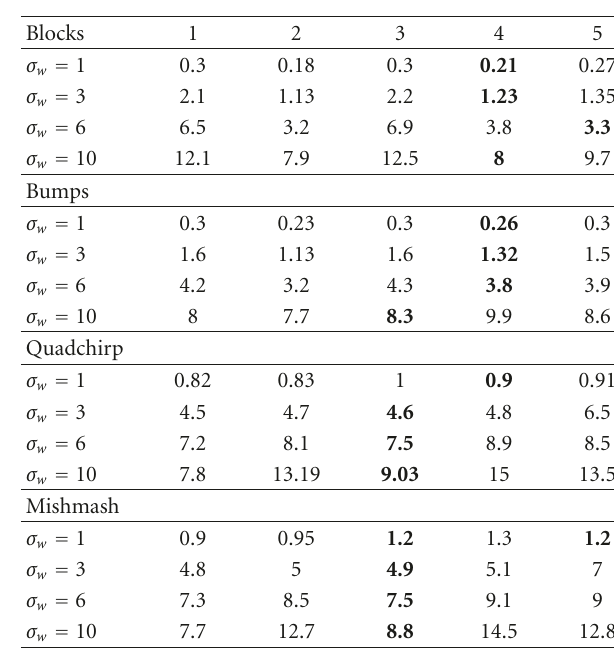
Table 3: MSE for (1) Optimum soft thresholding; (2) Optimum Subband-dependent soft thresholding; (3) MNDL soft thresh- olding, (4) MNDL Subband-dependent soft thresholding, (5)